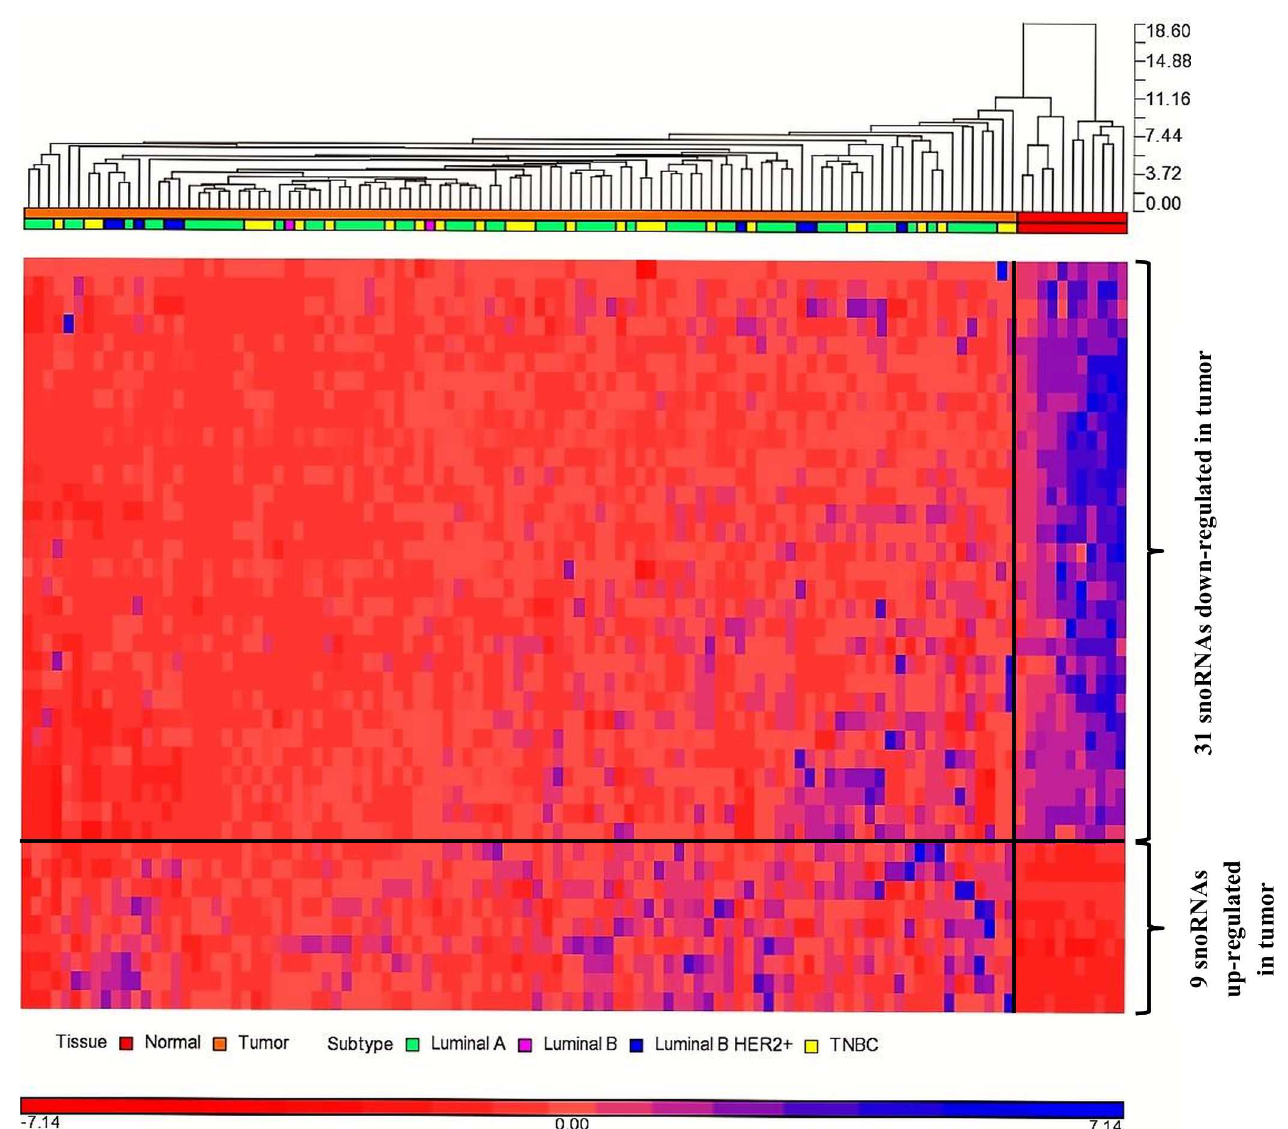
Fig 1. Hierarchical clusteringof differentially expressed snoRNAs. The 40 differentially expressed snoRNAs were subjectedto unsupervised hierarchicalclusteringwith average linkageand Euclideanas distance measure.The tumorsamples(orangehorizontalbars)were clearly separatedfromthe normalsamples